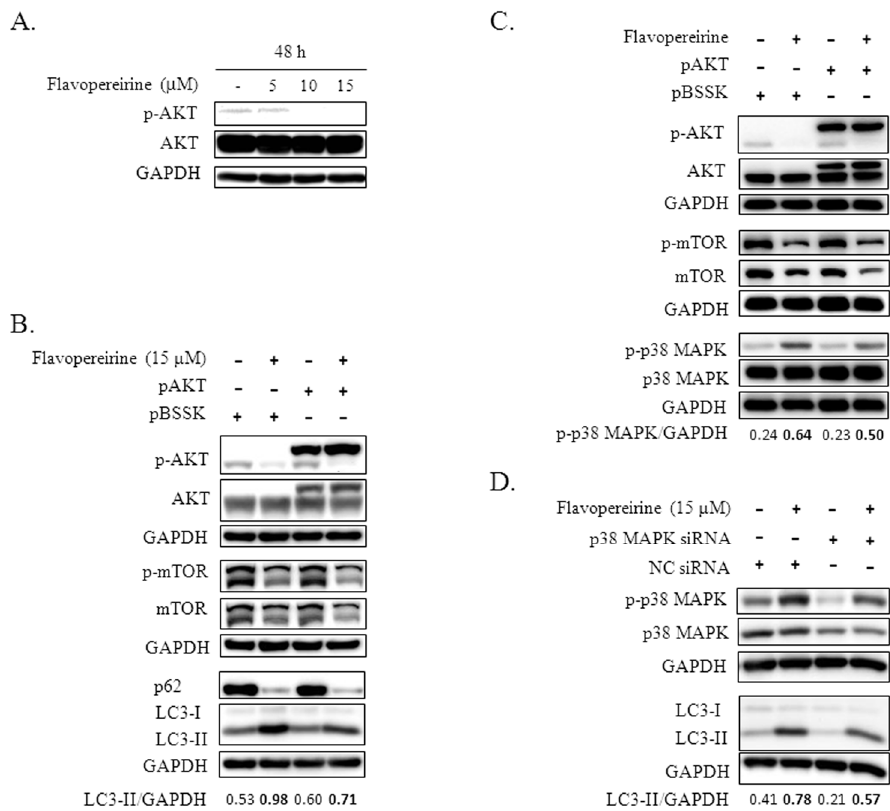
Figure 3. Flavopereirine inhibited autophagy through AKT/p38 MAPK signaling. ( A ) The